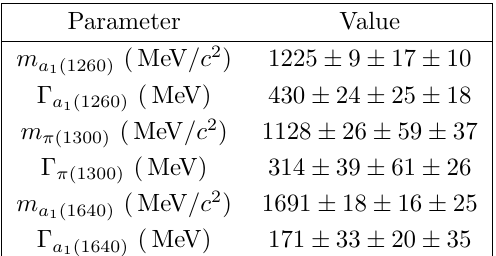
Table 4 . Resonance parameters determined from the (cid:12)t to D 0 ! (cid:25) + (cid:25) (cid:0) (cid:25) + (cid:25) (cid:0) decays. The uncer- tainties are statistical, systematic and model-dependent, respectively.